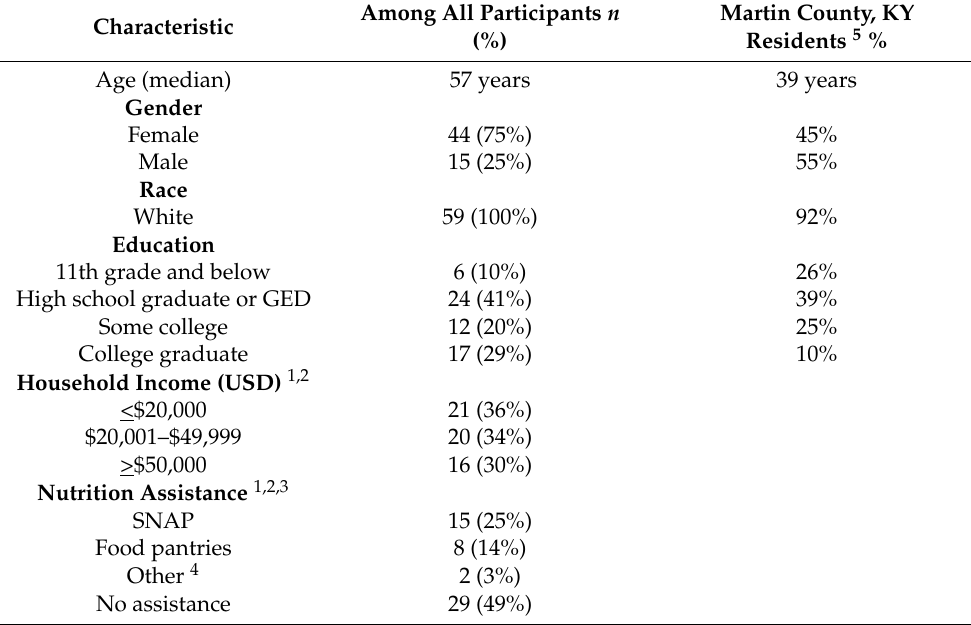
Table 1. Sociodemographic characteristics of focus group participants ( n = 59) and of Martin County, Kentucky residents, 2021.